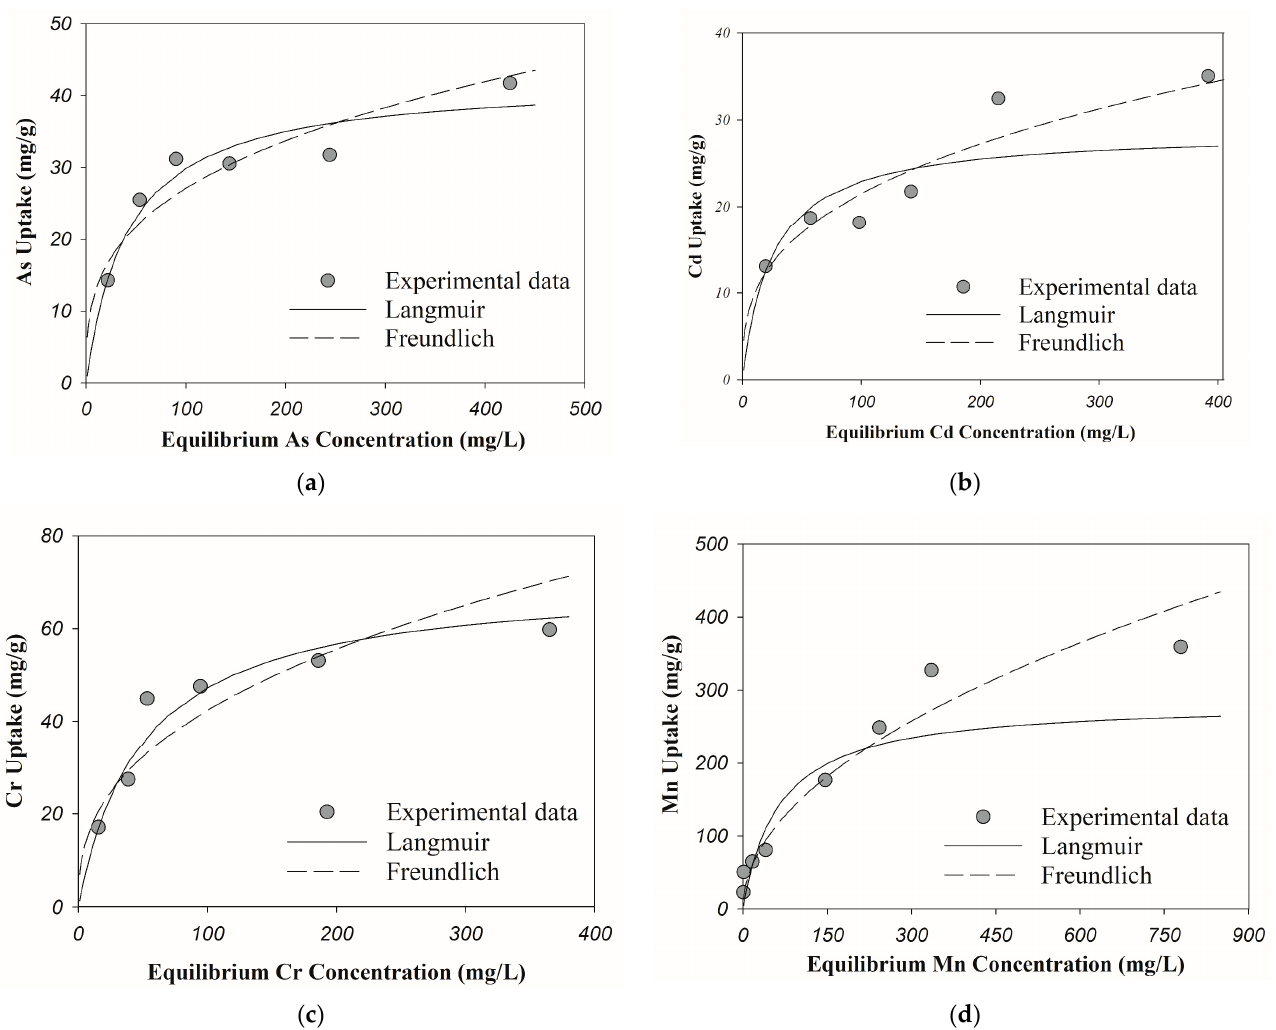
Figure 3. Adsorption isotherms of ( a ) As(V), ( b ) Cd(II), ( c ) Cr(VI), and ( d ) Mn(VII) by the rod-type biosorbent. The continuous lines were predicted by the Langmuir model; the dotted lines were produced by the Freundlich model (biomass dosage = 2 g/L, agitation rate = 200 rpm, temperature = 25 °C, Vw = 200 mL, and pH non shift (pH 5.5)). Table 4. Maximum uptakes of metals (As(V) and Cd(II)) by various biosorbents manufactured from sludge.